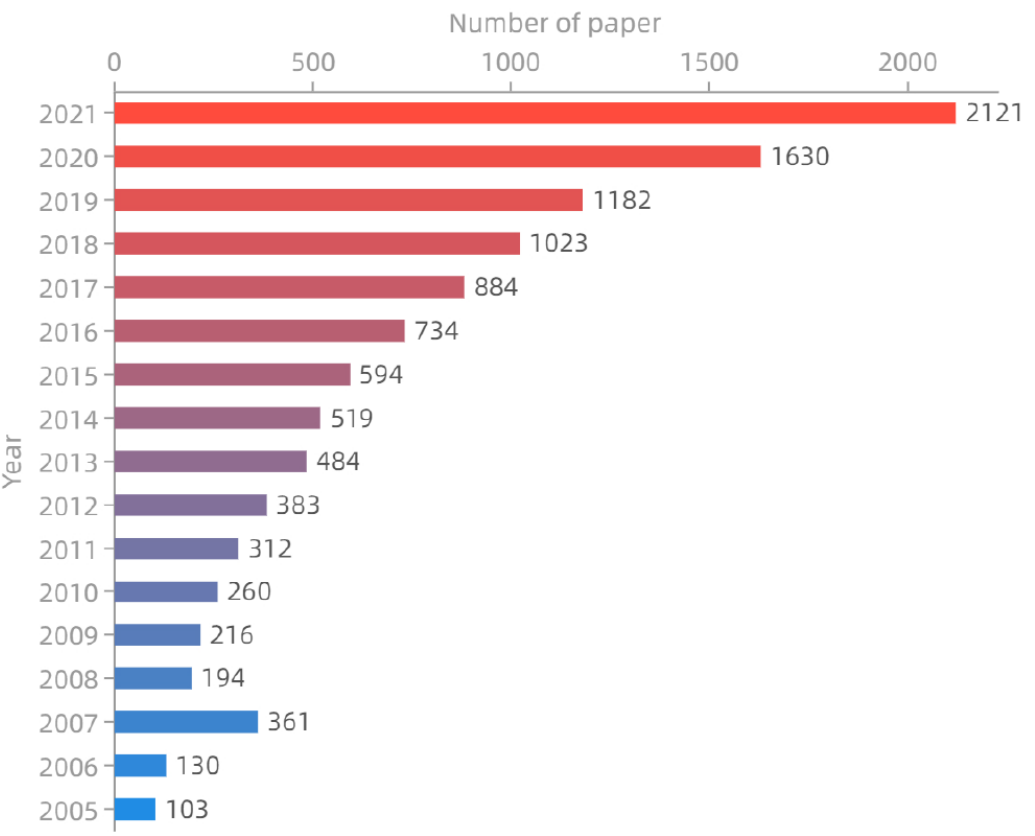
Figure 2. The summary of plant pan-genome papers in seventeen years. We have collected the data of the articles published in the plant pan-genome from 2005 to 2021 (Europe PMC). Especially in the last ten years, it has developed rapidly.